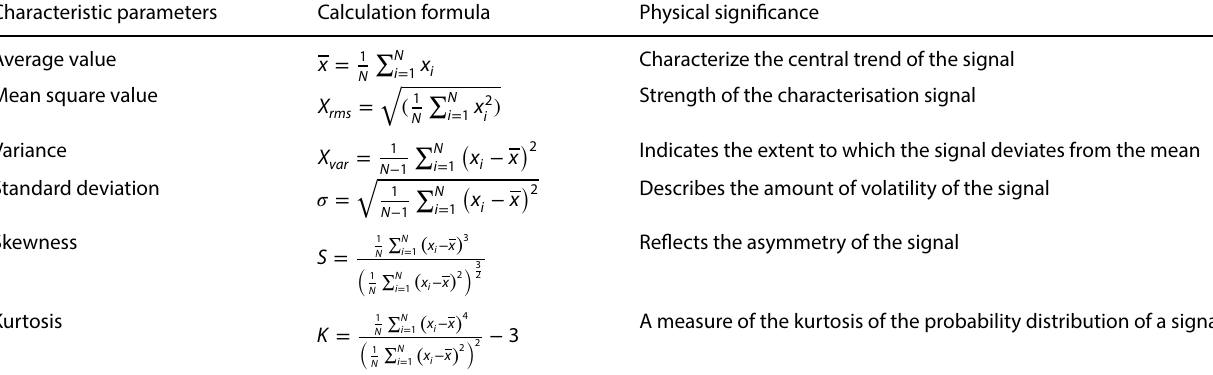
Table 3 Commonly used time-domain statistical parameters and calculation formulas Characteristic parameters